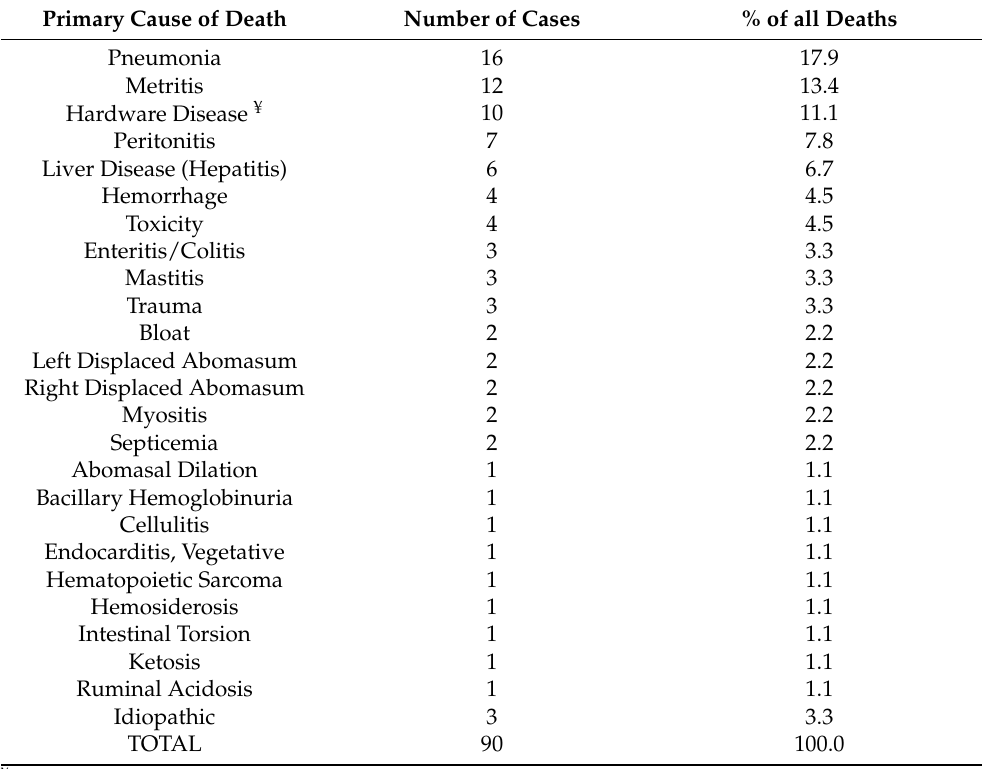
Table 7. Primary cause of death of 90 cattle > 1 year old to 4 years old diagnosed at